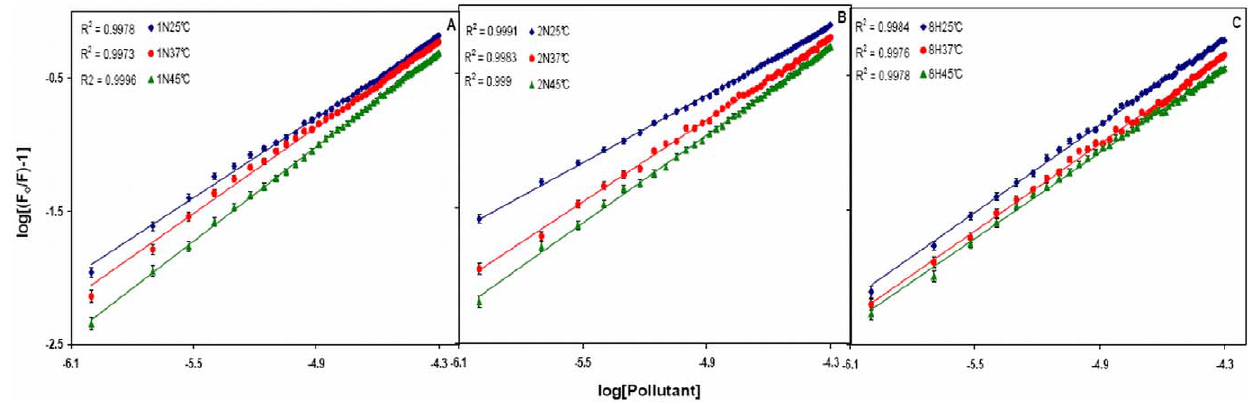
Figure 5. Plot between log [(F o /F)-1] and log[Pollutant] for HSA–pollutant interaction. (A) for HSA–1N, (B for HSA–2N) and (C) for HSA–8H at 25, 37 and 45 u C. [HSA=2 m M; 1N=2N=8H=0–50 m M].